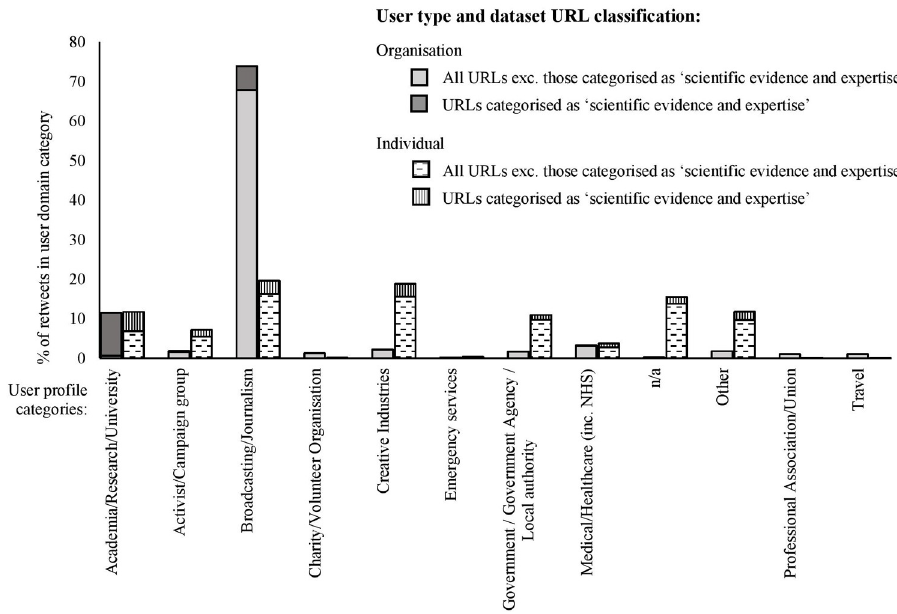
Fig 5. User profile profession categories and percentage of retweets for those classified as ‘organisations’ and ‘individuals’. User accounts classified as n/a are not included.